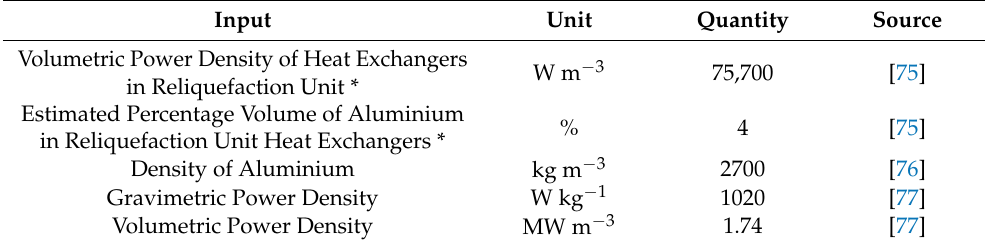
Table A3. Inputs for sizing the reliquefaction unit and generator [75–77].